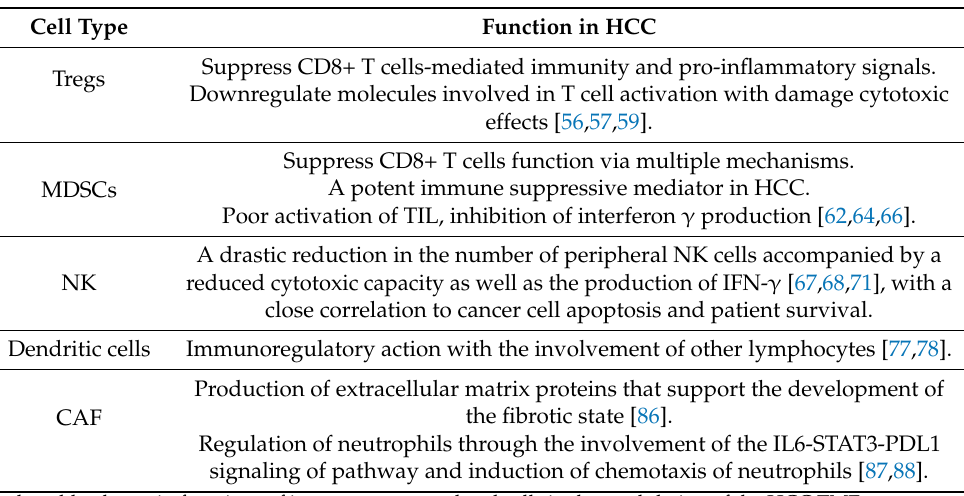
Table 2. Modulation of the TME by immune system-related cells in